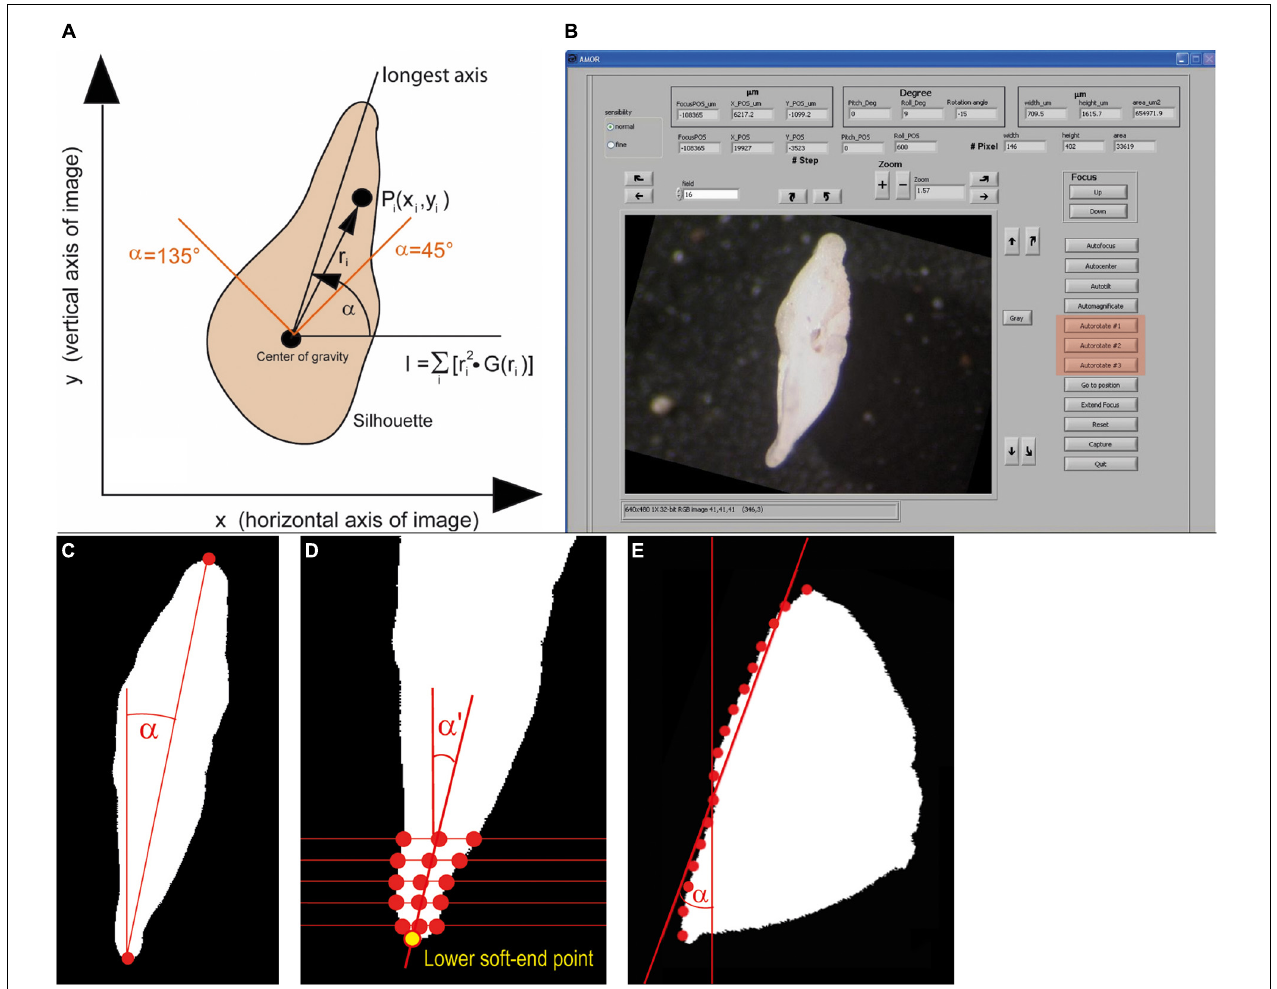
FIGURE 8 | Autorotate function. (A) A diagram illustrating the image momentum method for rotation (an image from Knappertsbusch et al., 2009). (B) GUI of System AMOR 2 in the manual mode, with buttons for soft rotations highlighted in red (see also Figure 10 ). The illustrated specimen is in an oblique position (compared with the “north–south” orientation in Figure 6B ). (C) Top–Down method. (D) Soft end point method, shown for the lower keel region. (E) Regression method. See text for further explanations. Panels (C–E) were redrawn after Oegerli